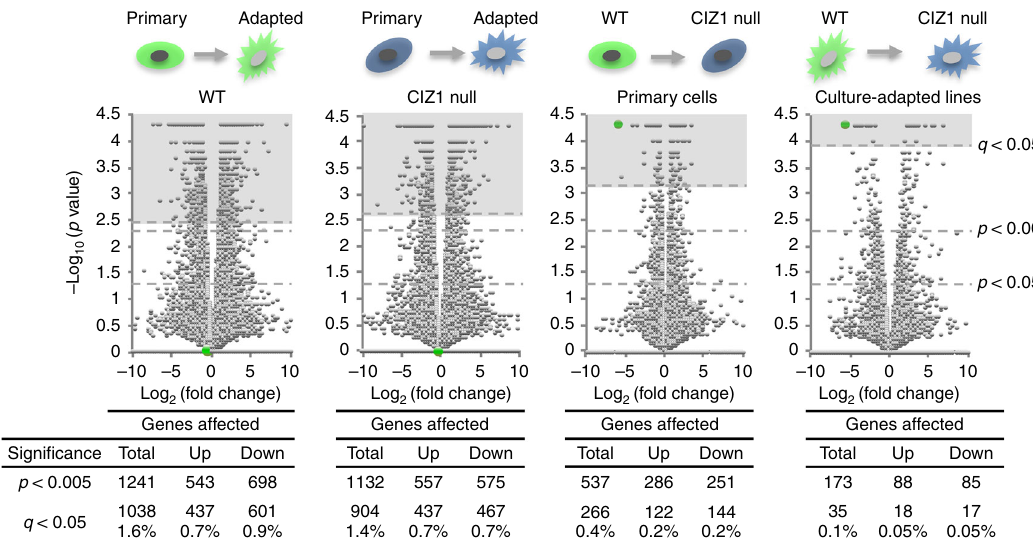
Fig. 2 Effect of loss of CIZ1 and culture adaption on gene expression. Volcano plots showing mean fold change in transcript level (FPKM) against signi fi cance ( P -value, calculated by cuffdiff) for all 65530 annotated transcription units assigned to mouse genome assembly GRCm38, derived from whole transcriptome RNA-seq of three primary WT (13.1 p4, 13.8 p4, 14.4 p4) embryonic fi broblast populations and culture-adapted cell lines derived from the same primary cells, and three primary CIZ1 null (13.15 p3, 13.17 p3, 14.2 p4) embryonic fi broblast populations and culture-adapted cell lines derived from the same primary cells. CIZ1 is indicated in green. The populations of cells being compared are indicated above each plot. Below, the number of transcription units affected at the indicated signi fi cance thresholds. Signi fi cantly affected gene lists ( q < 0.05, calculated by cuffdiff) are in